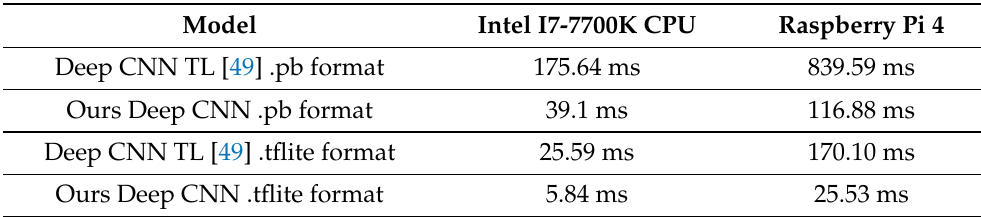
Figure 13. Confusion matrix of Deep CNN on test set of SaR dog search and rescue dataset. Table 8. Mean inference time measure in milliseconds for each